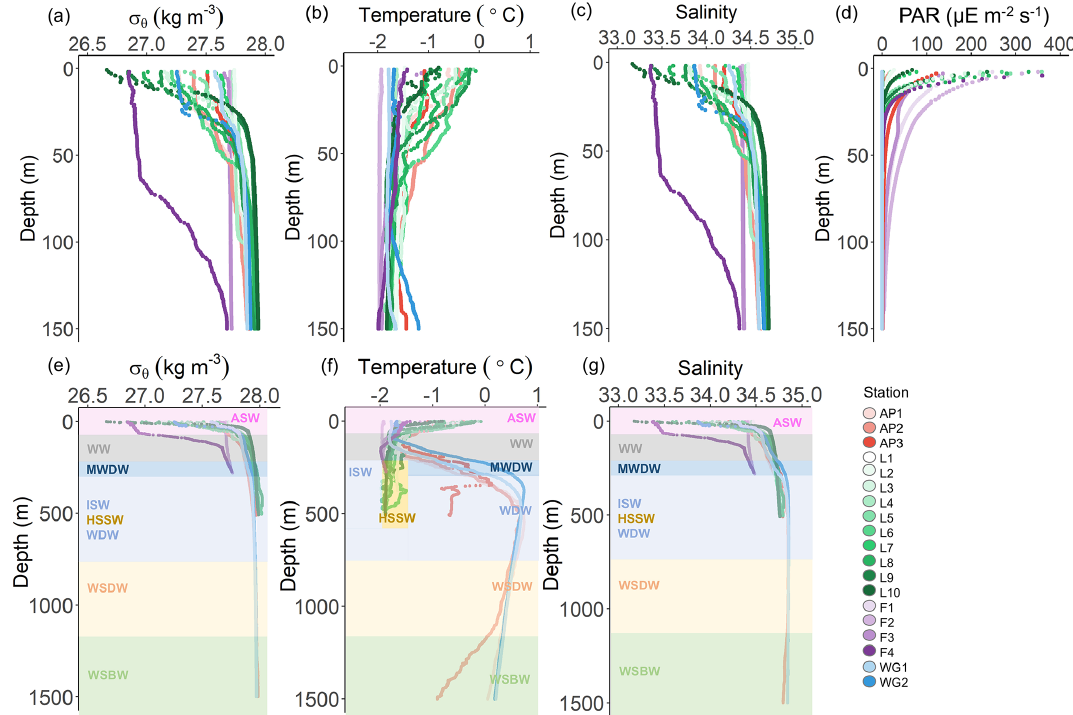
Figure 2. Depth profiles of (a) potential density ( σ θ ), (b) potential temperature, (c) absolute salinity, and (d) photosynthetically active radiation (PAR) in the upper 150m and (e) σ θ , (f) potential temperature, and (g) absolute salinity in the upper 1500m at all stations. The water masses present at each station, identified by their temperature and salinity characteristics, are denoted in panels (e–g) as follows: WSBW – Weddell Sea Bottom Water, WSDW – Weddell Sea Deep Water, WDW – Warm Deep Water, MWDW – Modified Warm Deep Water, ISW – Ice Shelf Water, HSSW – High Salinity Shelf Water, WW – Winter Water, and ASW – Antarctic Surface Water. In panel (f) , the dark yellow rectangle indicates HSSW. The general station locations are indicated by the different marker colours: red shades – Antarctic Peninsula, green shades – Larsen C Ice Shelf, blue shades –Weddell Gyre, light purple shades – early-summer Fimbul Ice Shelf, and dark purple – late-summer Fimbul Ice